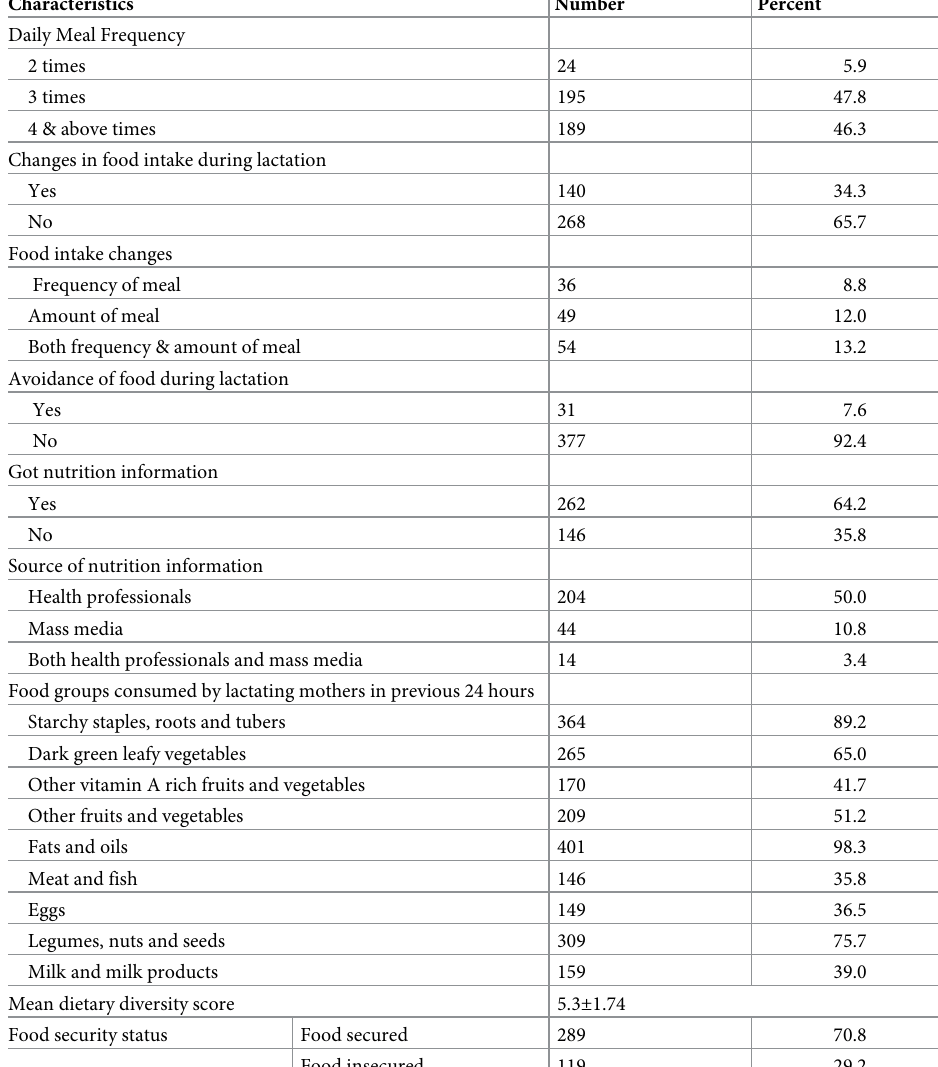
Table 2. Eating habits, dietary diversity and food security status of lactating mothers (n = 408) visiting govern- mental health facilities, Dessie town, Ethiopia, March-April, 2017.